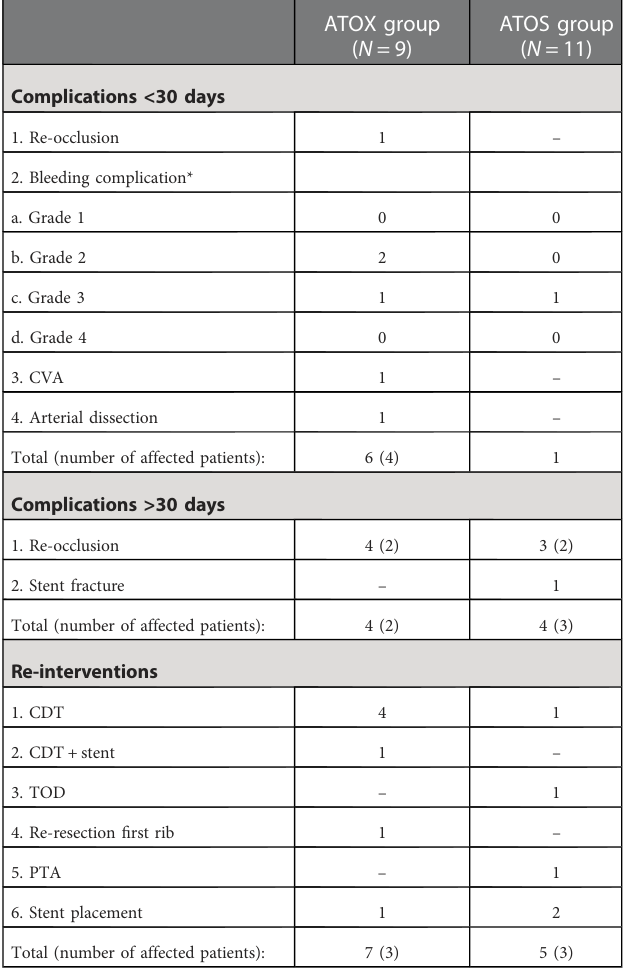
TABLE 3 Complications and re-interventions.